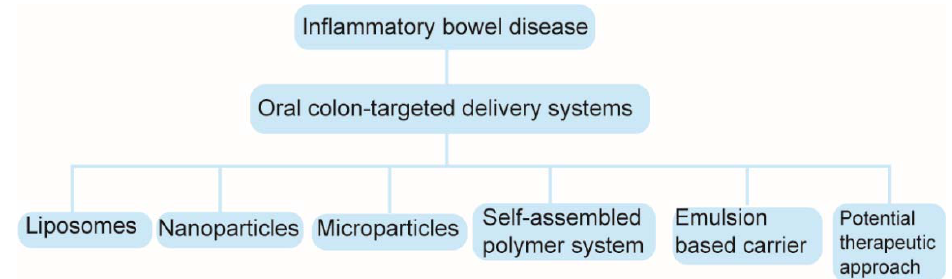
Figure 1. Structural diagram of oral colon-targeted delivery systems in IBD.